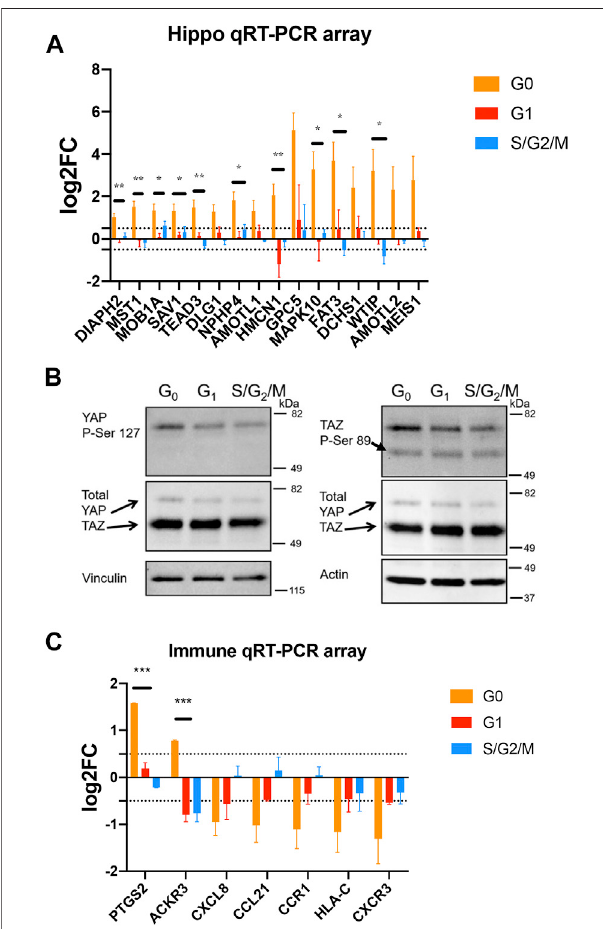
FIGURE5| Quiescentprostatecancercellsexhibitalteredexpressionof Hippo pathway components and immune-related genes. (A, C) PC3 Venus/ Cherry cells were sorted into G0, G1 and S,G2/M fractions for gene expression analysis using Qiagen qRT-PCR arrays. Biological quadruplicates were run on the Hippo Signaling Pathway array and triplicates were run on the Qiagen Cancer Immunology qRT-PCR array. All changes in expression are normalized to asynchronous cells. Selected genes are shown here, the full dataset is shown in the Supplementary Figure S4B . (A) G0 cells show a consistent increase in transcripts for Hippo signaling pathway components including positive and negative regulators as well as feedback targets. (B) PC3 Venus/Cherry cells were sorted into G0, G1 and S,G2/M fractions forprotein isolation and western blotting. G0cells exhibitan increase in phosphorylated YAP consistent with active Hippo signaling, but little effect on TAZ (note TAZ protein encoded by WWTR1 gene). (C) G0 cells exhibit an altered immune expression pro fi le while G1, S and G2/M cells exhibit few signi fi cant changes. CXCL8, CCL21, CCR1, HLA-C and CXCR3 were all signi fi cantlydifferentfromasynchronouscontrolsbya2-foldcutoffand t -tests with p < 0.02. For all gene expression data in A and C, G0 cells were also compared to G1 or S/G2/M cells by unpaired t -tests. * indicates p < 0.05, ** indicates p < 0.01, *** indicates p < 0.005.